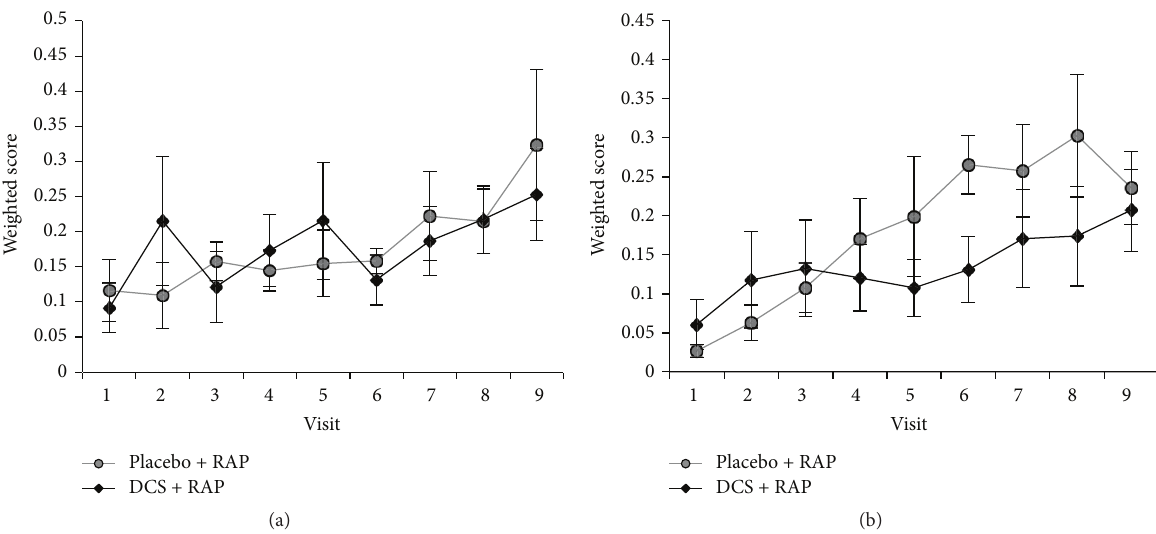
Figure 2: Robotic weighted score. Weighted scores on 6 times during which placebo or D-cycloserine (D-cycloserine) at 100 mg dose was dispensed. Across all subjects, mean weighted score on the (a) balloon game and (b) thera-pong improved significantly, from baseline to end of week 1, to week 2, and to week 3. However, there were no significant differences according to treatment group or interaction for any of these time